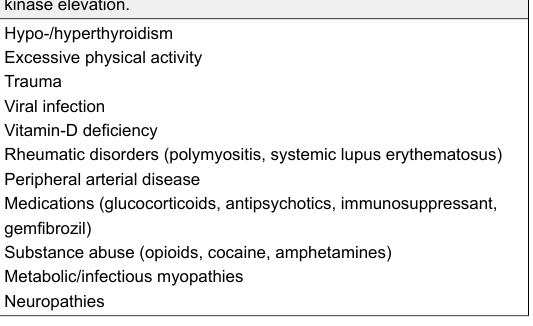
Table 2: Risk factors and precipitating factors of statin-associated myopathy. Adapted with permission from